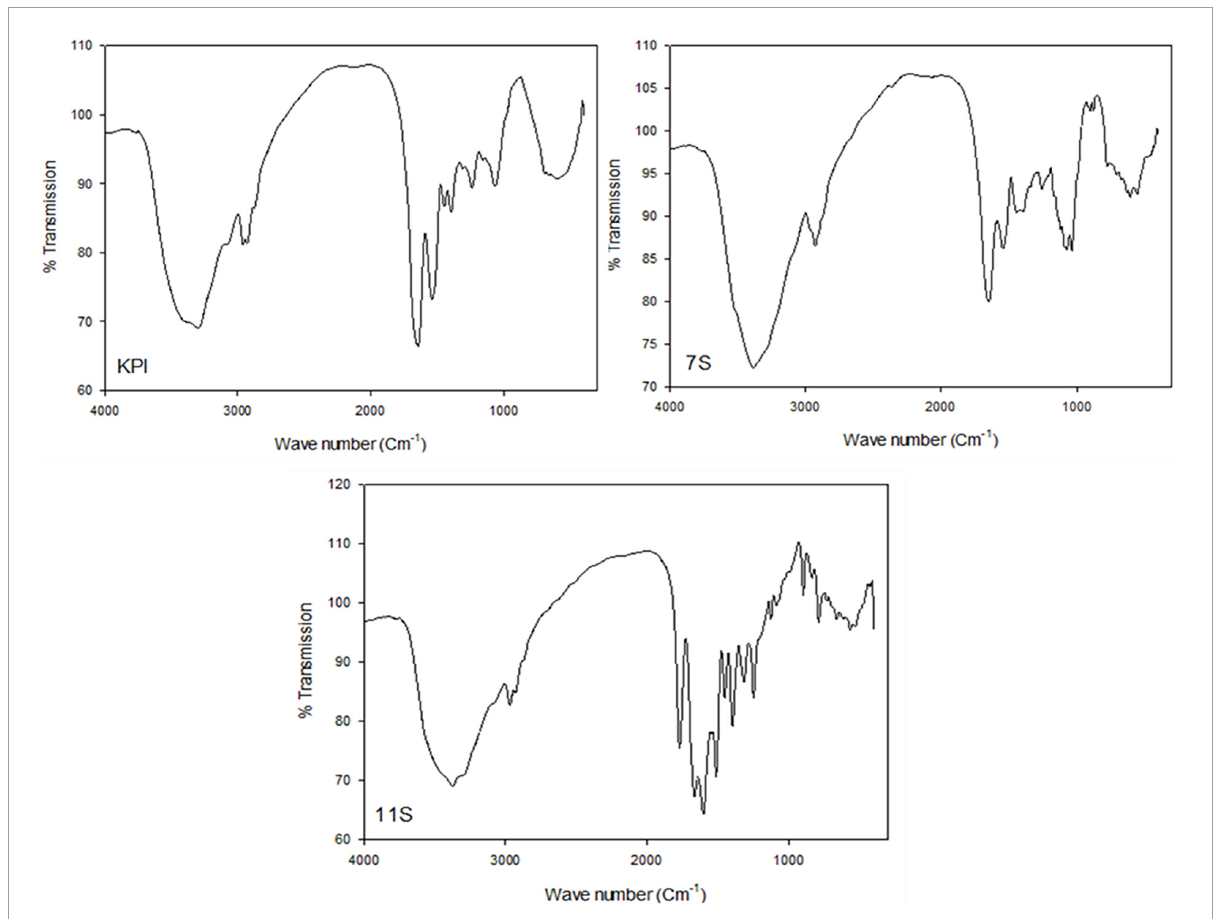
FIGURE6 FTIR different spectra of red kidney bean protein isolate (KPI), 7S globulin (7S) and 11S globulin